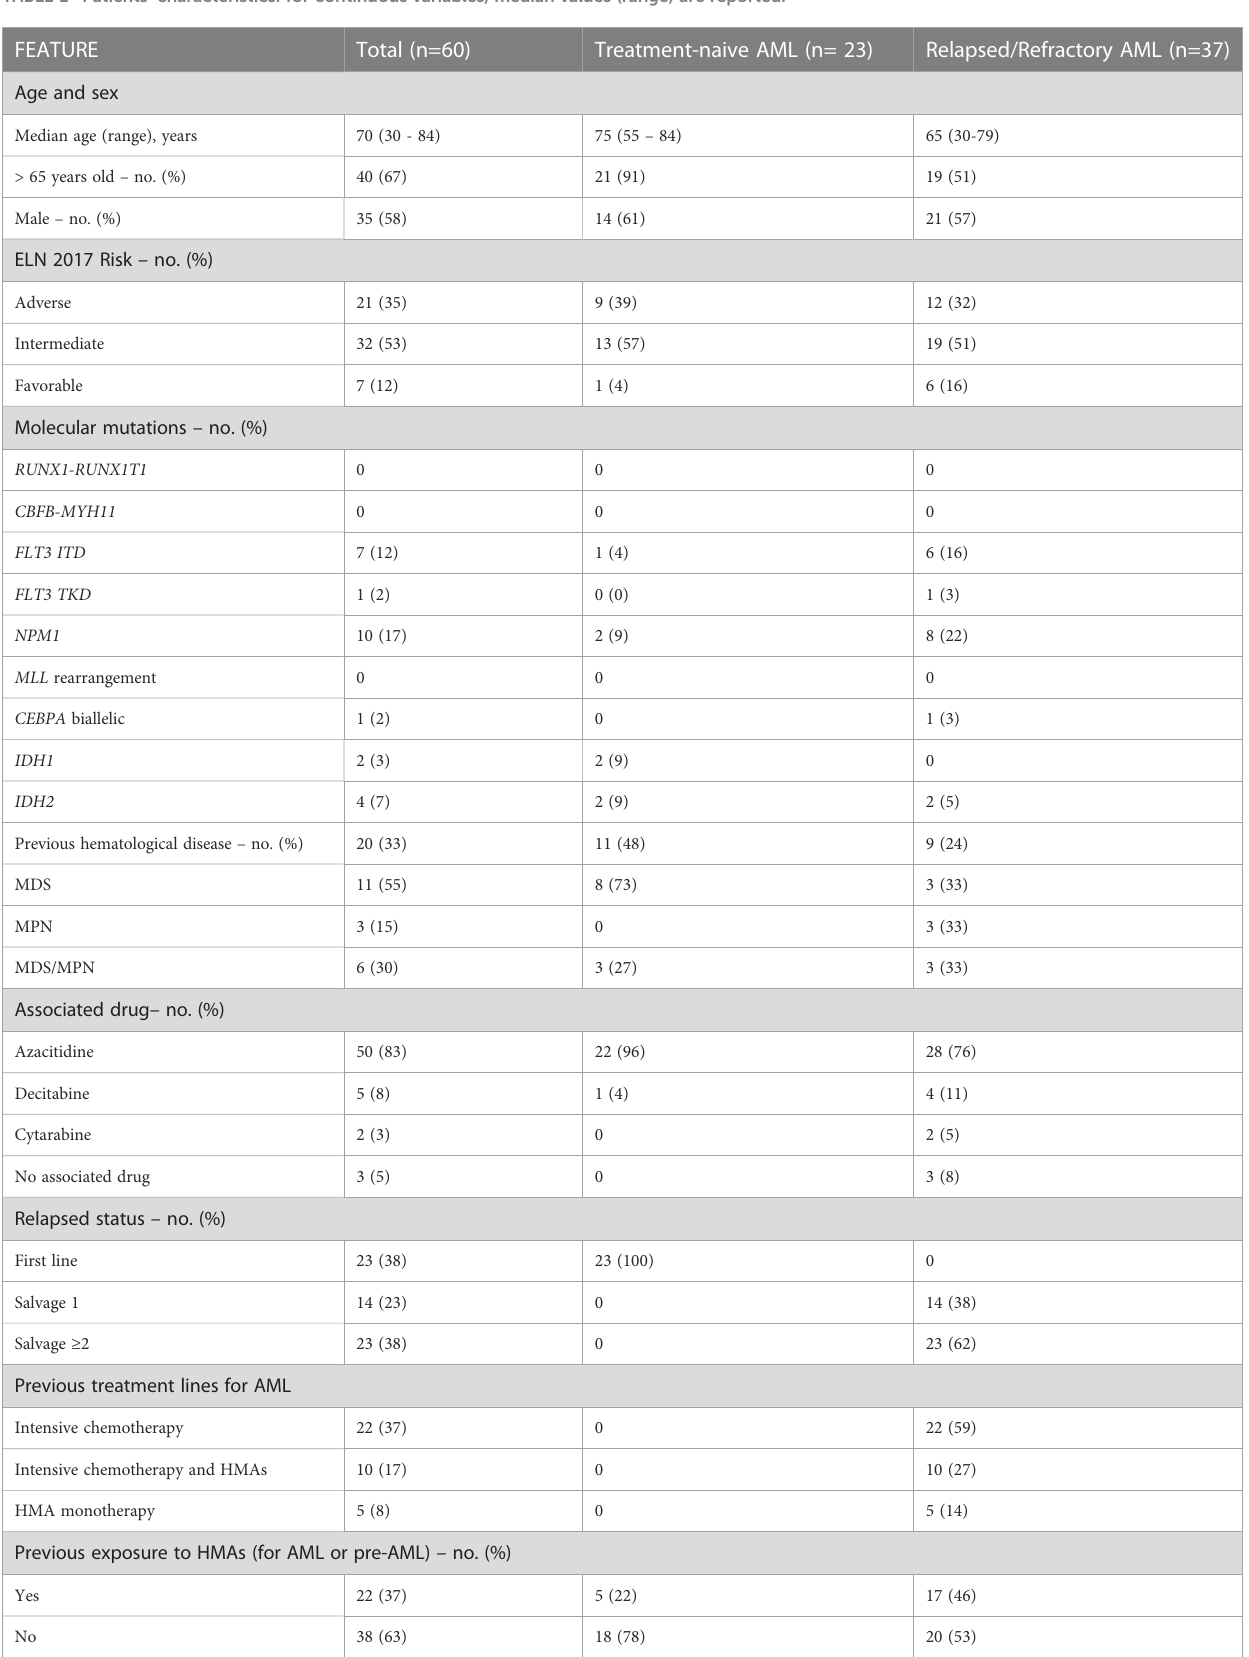
TABLE 1 Patients ’ characteristics: for continuous variables, median values (range) are